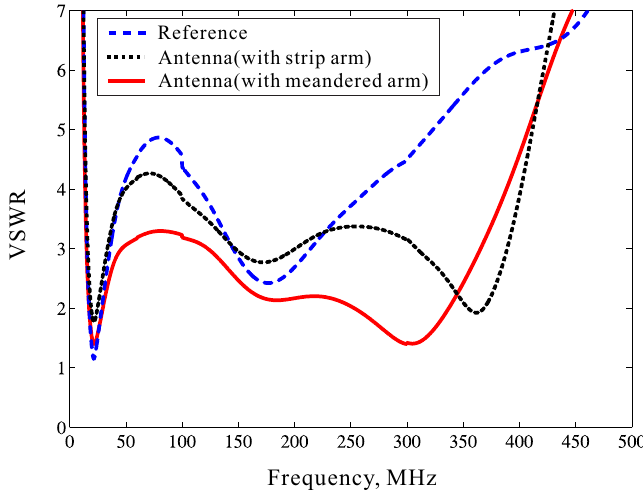
Figure 6. Simulated VSWR characteristics of three types of